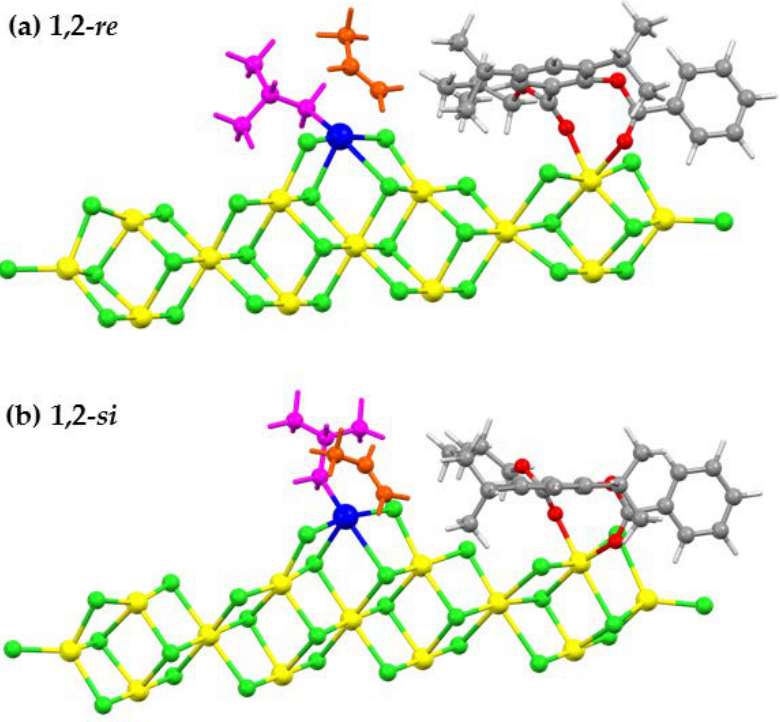
Figure 5. Structures of the π -complex of ( a ) 1,2- re and ( b ) 1,2- si insertions of the ZN-catalyzed PP polymerization with the salicylate (SID-4) donor. Table 4. The π - complex formation energy (ΔE π ), the intrinsic activation energy (E a ), the relative barrier (Rel.), and the apparent activation energy (E a (app)) of the ZN-catalyzed PP polymerization with the five salicylate donors together with values of transition state imaginary frequencies ( ν ).